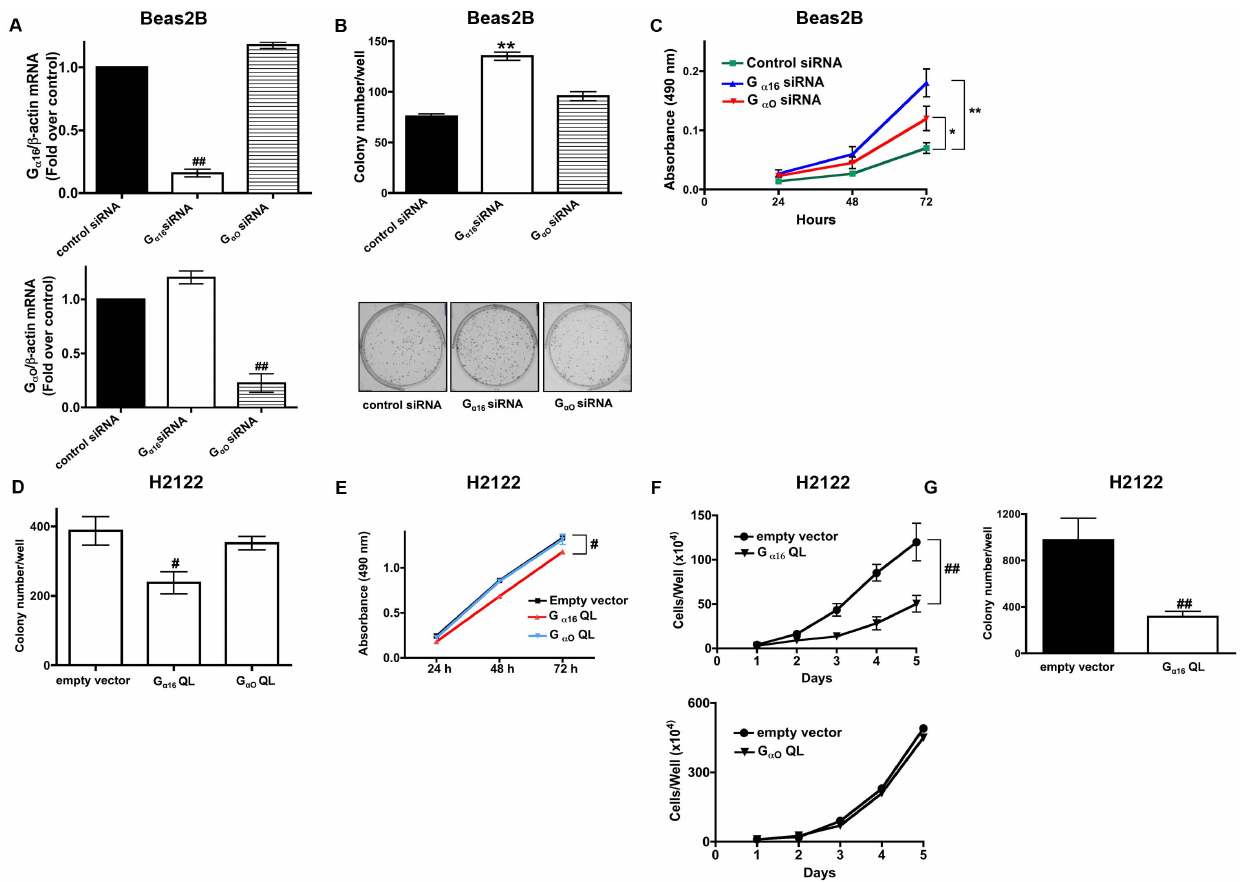
Figure 3. G a 16 regulates NSCLC cell proliferation. A. Beas2B cells were transfected with either control siRNA or siRNAs specific to G a 16 or G a o . Total RNA was isolated and analyzed for the expression of G a 16 or G a o using quantitative PCR. Normalized G a 16 or G a o mRNA levels to that of b -actin mRNA were represented in the graphs. ## , p , 0.01; versus control siRNA. Beas2B cells were transfected with either control siRNA or siRNAs-specific to G a 16 or G a o and cell proliferation rates were later determined either by using a clonogenic assay (B) or an MTS assay (C) as described in the Methods. Upper panel represents mean 6 SEM from two independent highly reproducible experiments, while representative images were displayed in the lower panel. Data represents mean 6 SEM from three independent highly reproducible experiments. *, p , 0.05; **, p , 0.01; versus control siRNA. H2122 cells were transfected either with empty vector or constitutively active G a 16 Q212L or G a o Q205L expression vectors and the cell proliferation rates were later determined using either a clonogenic assay (D), an MTS assay (E) or five-day cell growth curve analysis (F) as described in the Methods. Upper panel represents mean 6 SEM from two independent highly reproducible experiments, while representative images were displayed in the lower panel. Data represents mean 6 SEM from three independent highly reproducible experiments. # , p , 0.05; G, H2122 cells were transfected with either empty vector or constitutively active G a 16 Q212L and the abilities of the transfected cells to grow on soft agar were later probed. Data represents mean 6 SEM from three independent highly reproducible experiments. ## , p , 0.01; versus empty vector control.